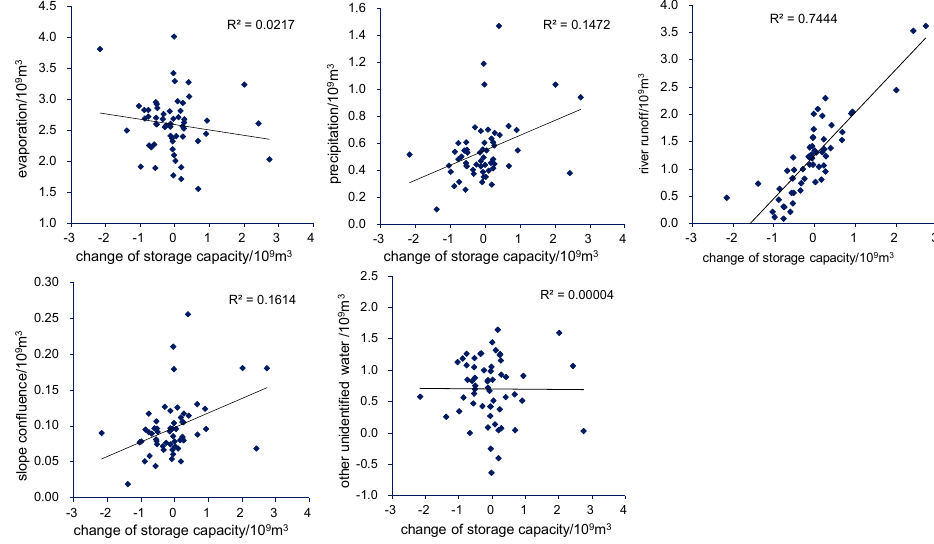
Figure 10. Analysis of the correlation between the change in the storage capacity and the other terms in the water-balance equation.